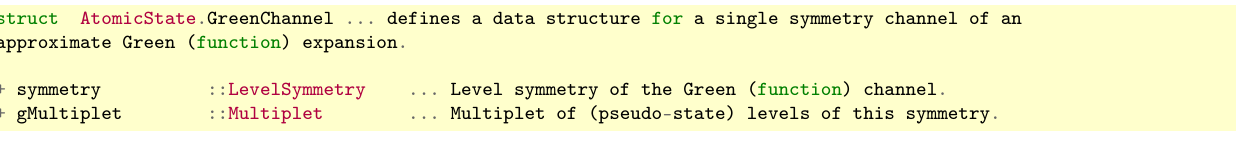
Figure 3. Definition of the data structure AtomicState.GreenChannel in J AC that help retain the representation of a single channel (continuum) of the approximate Green function